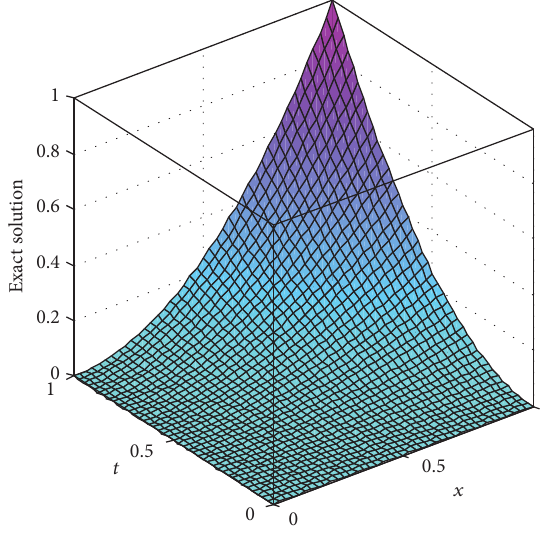
Figure 4: Exact solution for Example 1.